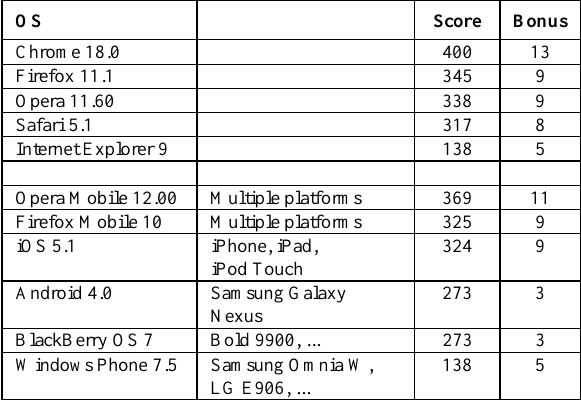
Table1: Browser ranking related to HTML5 support derived from http://html5test.com (15 April